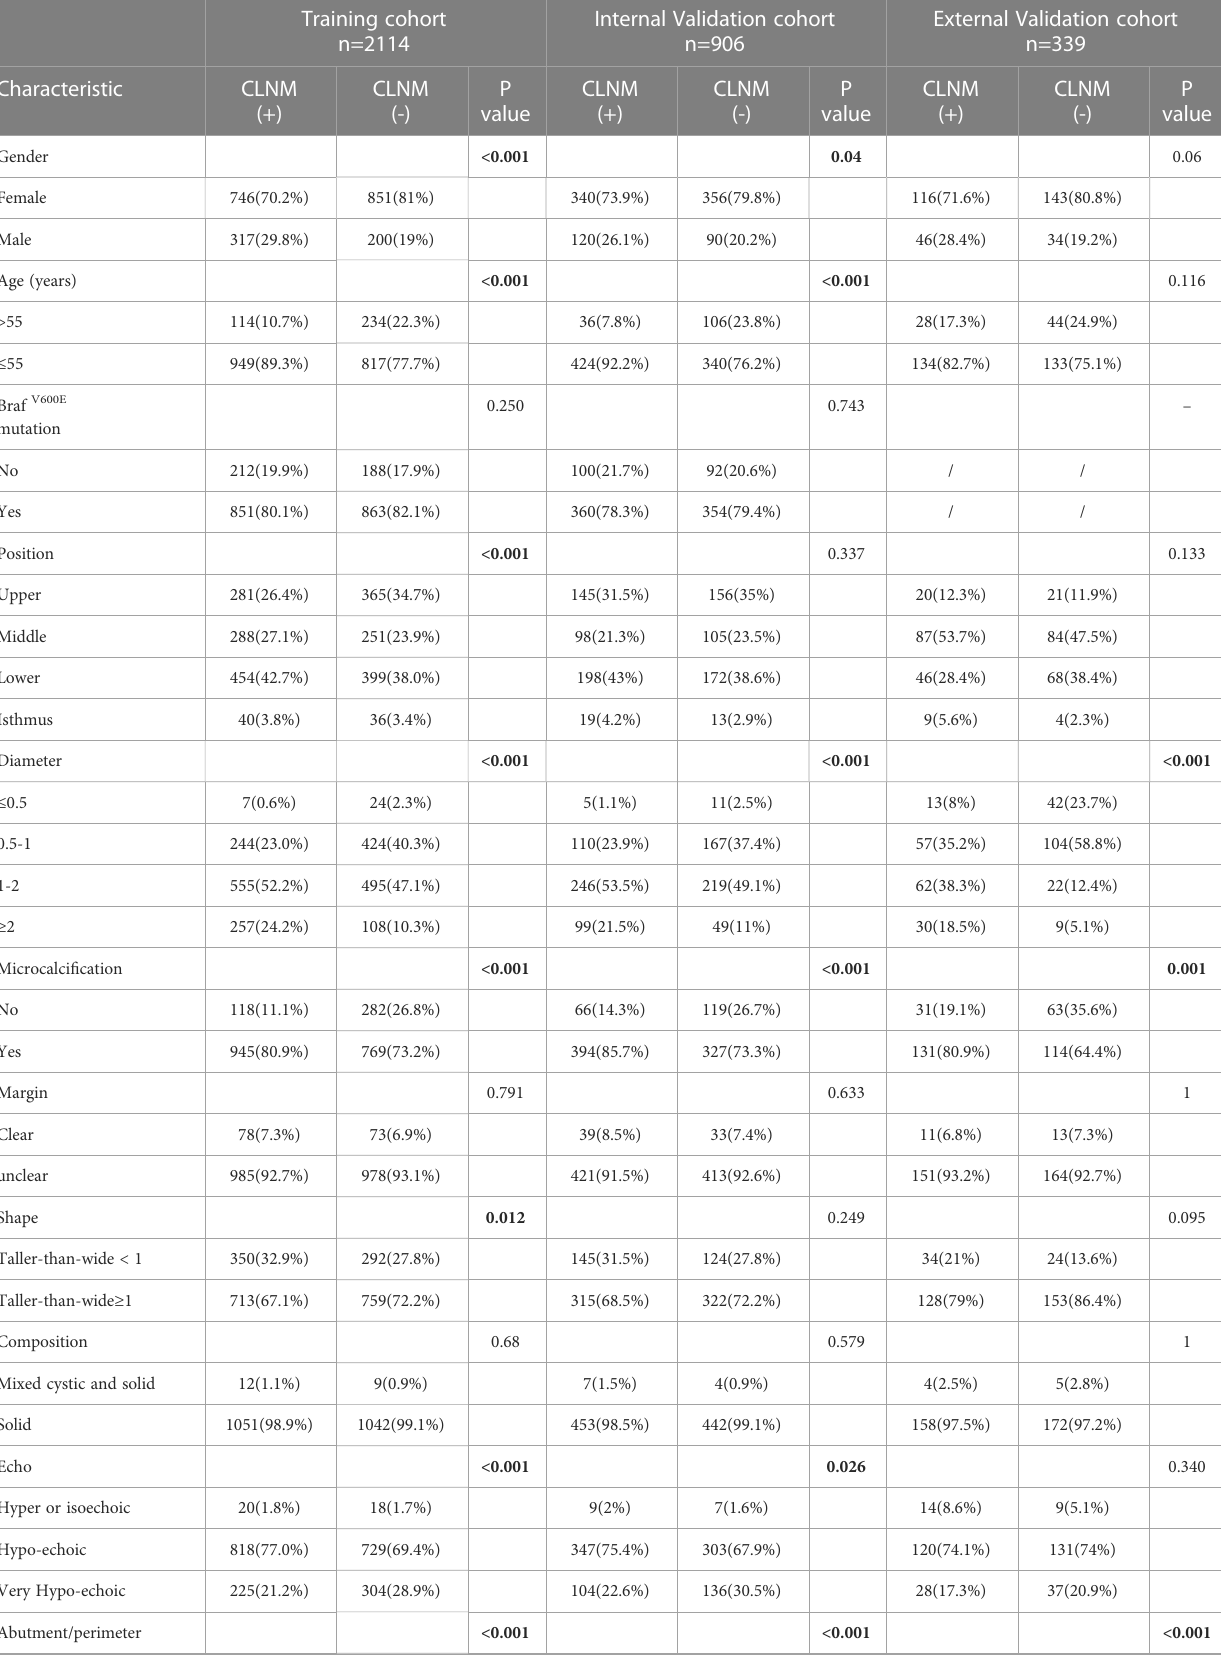
TABLE 1 Clinicopathological and sonographic characteristics of patients in PTC by central lymph node